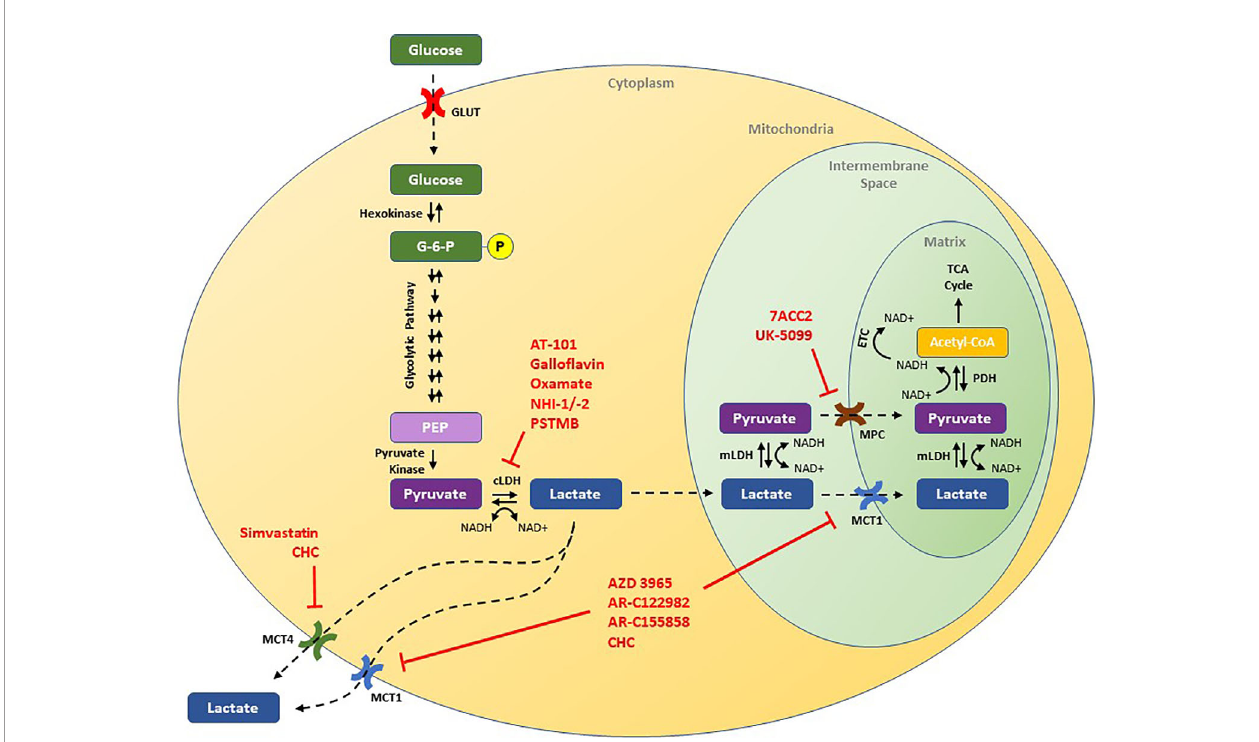
FIGURE 1 | Schematic of the lactate pathway and illustration of novel therapeutic strategies that have been shown to decrease tumor growth in preclinical studies. Drugs discussed in this review are presented in red and are shown by their putative target of action. ECT, electron transport chain; G-6-P, glucose-6-phosphate; GLUT, glucose transporter; cLDH, cytosolic lactate dehydrogenase; mLDH, mitochondrial lactate dehydrogenase; MCT1, monocarboxylate transporter 1; MCT4, monocarboxylate transporter 4; MPC, mitochondrial pyruvate carrier; NAD+, nicotinamide adenine dinucleotide (oxidized); NADH, nicotinamide adenine dinucleotide (reduced); PEP, phosphoenolpyruvate; PDH, pyruvate